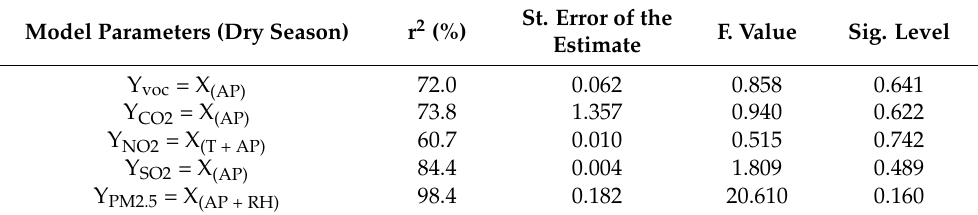
Table 5. Influence of meteorological parameters on air pollutant parameters (dry season). Model Parameters (Dry